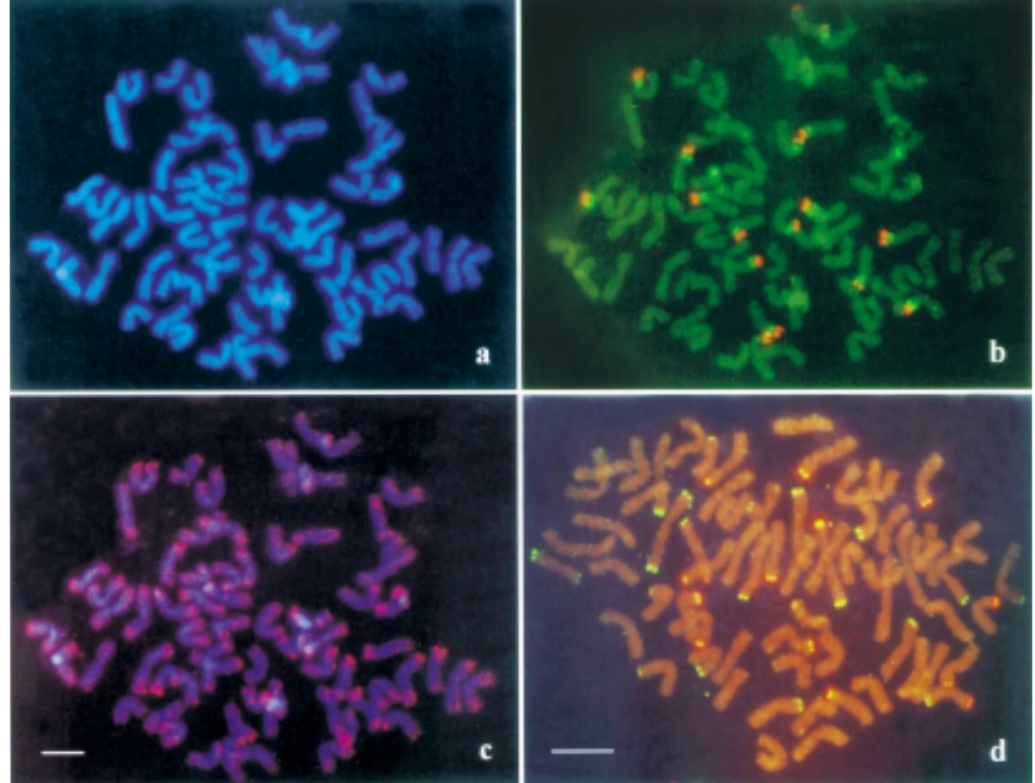
Figure 1 - Location of specific sites in the chromosomes of Thinopyrum ponticum . a. Complete metaphase with 2n = 70 DAPI stained chromosomes. b. The same cell showing seventeen 45S rDNA sites (red) and 20 sites of 5S rDNA (green). c. Reprobing of the same cell revealing the distribution of the highly repetitive DNA sequence pAs1. d. Partial prometaphase displaying 15 sites of 45S rDNA (red) and the terminal locating of the pSc119.2 probe (green). Bars = 10 µ